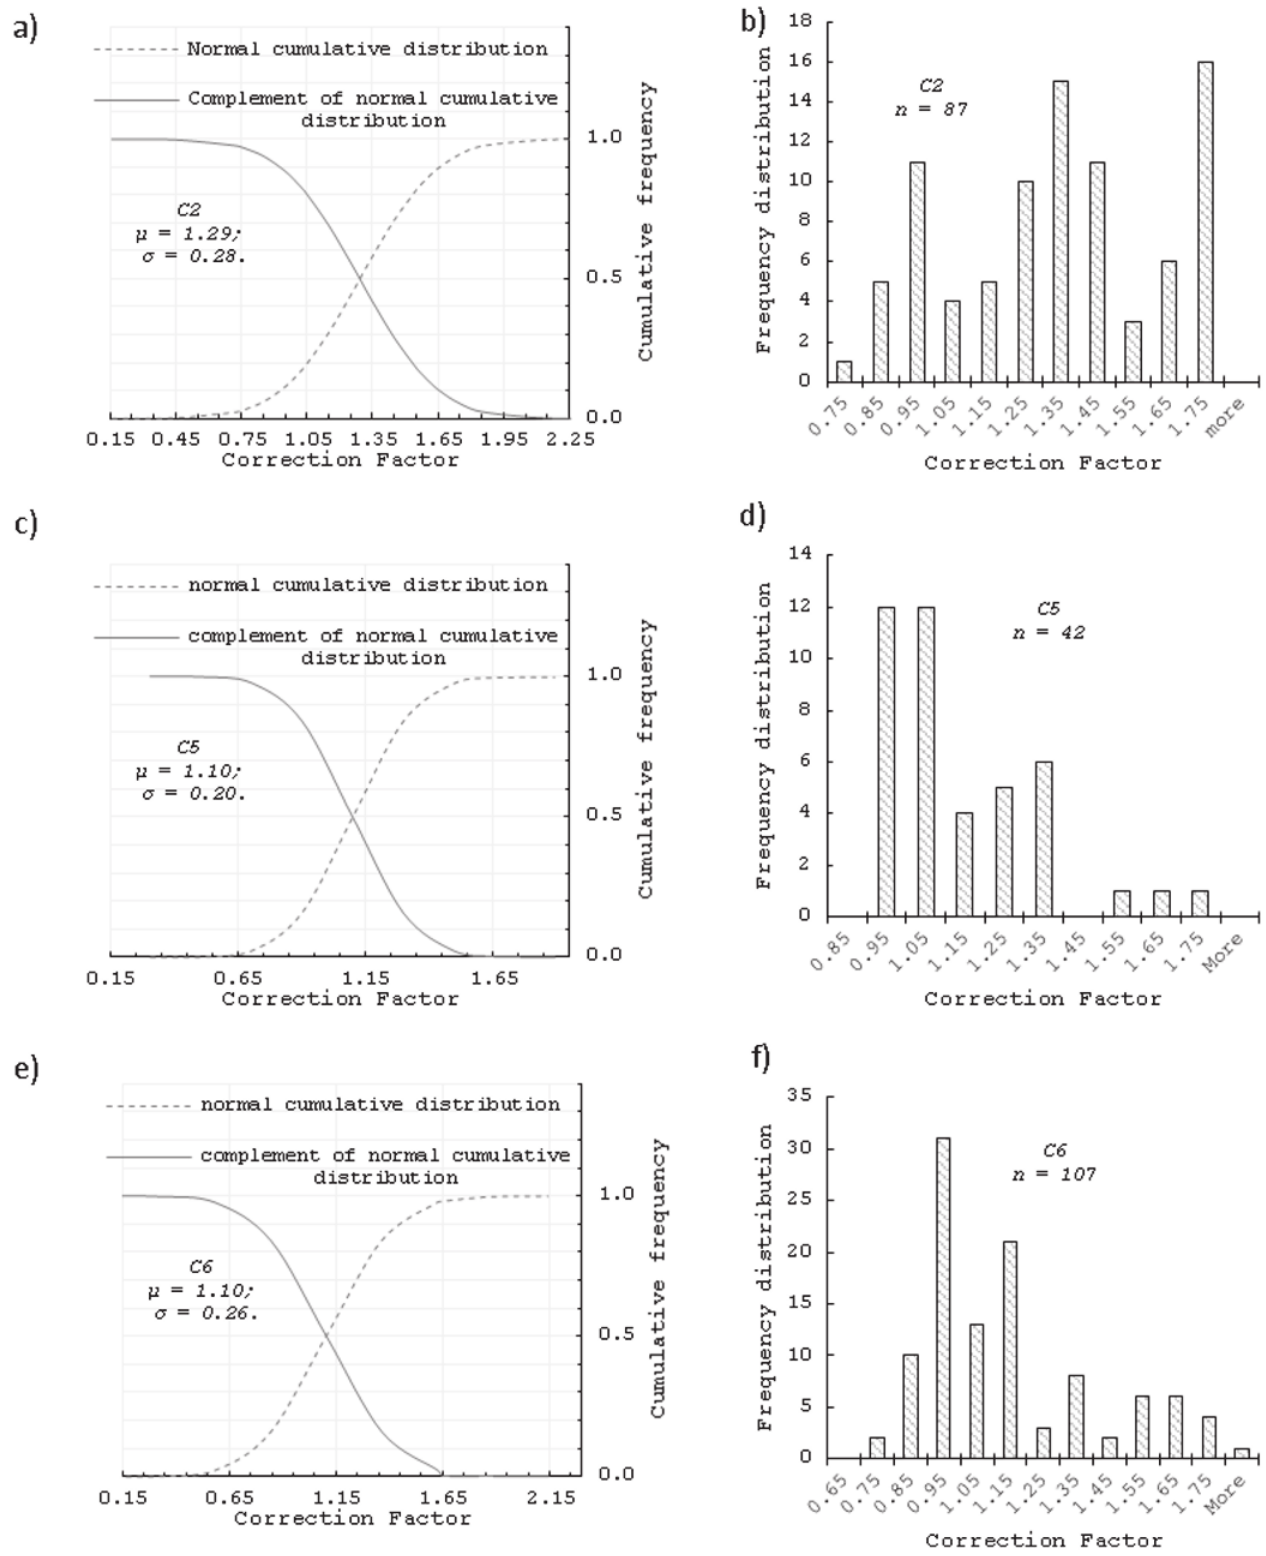
Cumulative Gaussian distribution curve and frequency distribution for the correction factors of concretes C2, C5 and